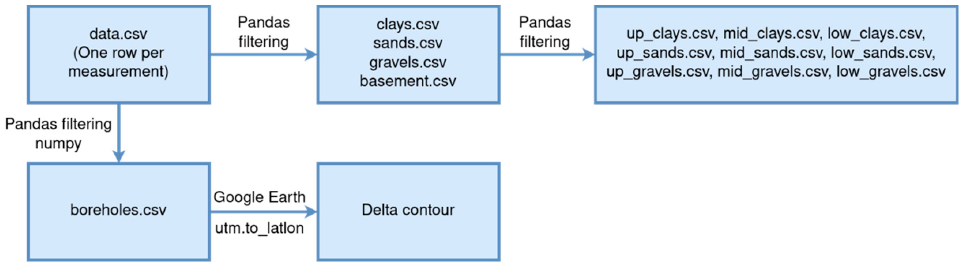
Figure 4. Flow diagram showing the data compilation stage.